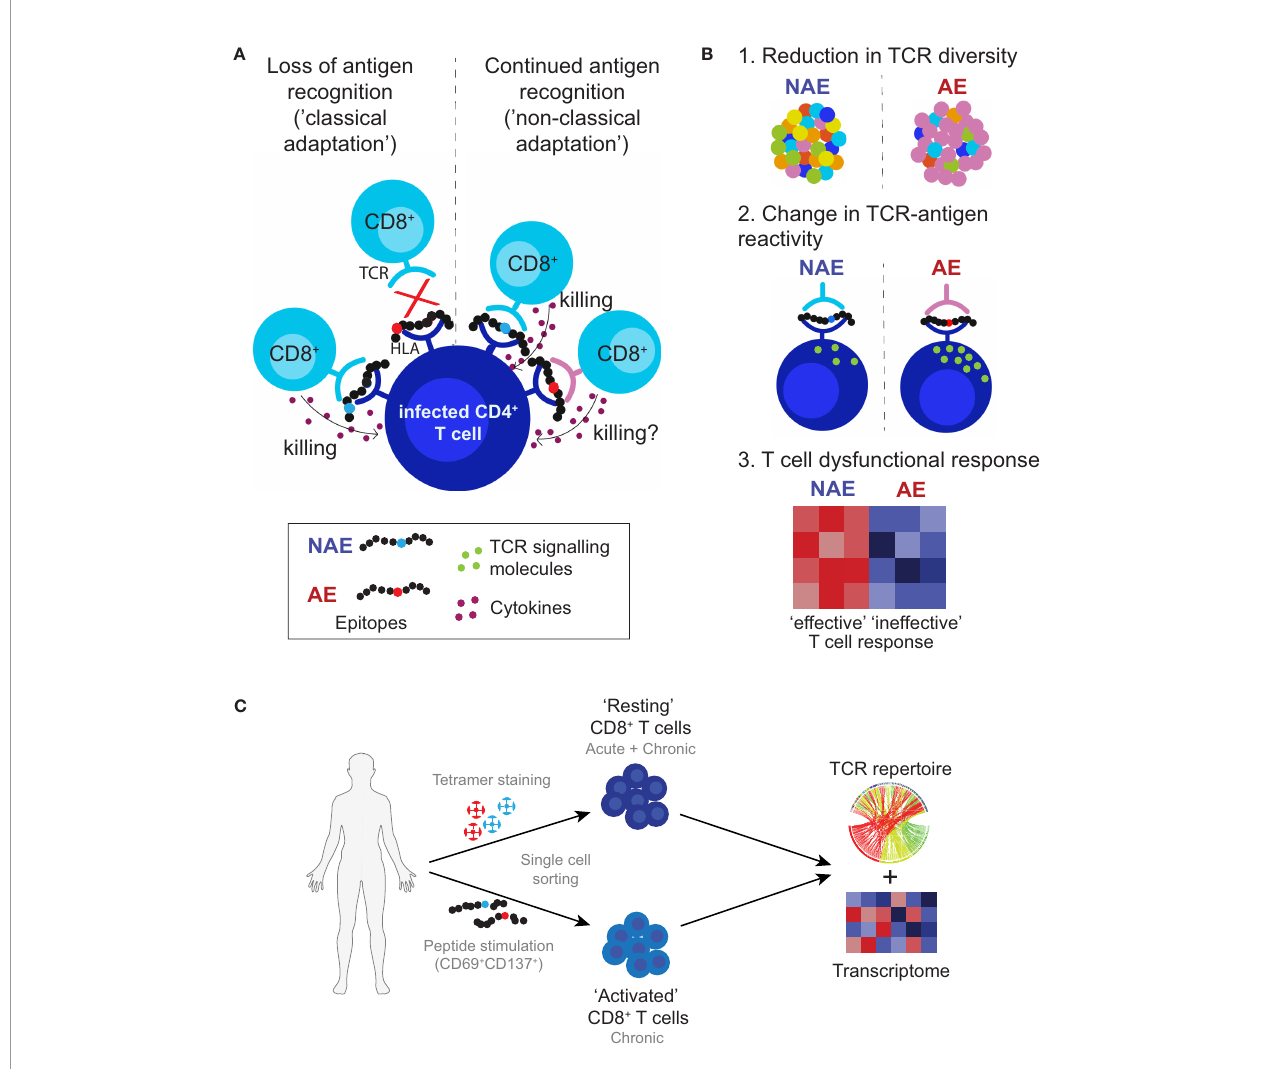
FIGURE 1 | Proposed viral adaptation strategies against anti-HIV T cell immune responses. (A) Schematic depicts classical and non-classical adaptation based on recognition of the HLA-peptide complex by the TCR. (B) Lists the three main proposed mechanisms of non-classical adaptation tested in this study: 1. reduction in TCR diversity or activation of new TCR clonotypes; 2. differences in TCR-peptide-HLA antigen speci fi c reactivity that affect T cell signalling; and 3. alterations in the interaction between the TCR and HLA-peptide complex leading to ineffective T cell responses. (C) Approach used in this study to identify and characterize antigen- speci fi c CD8 + T cells. Cells were single cell sorted using HLA class I tetramers for the NAE- and AE-form of an epitope (assigned as ‘ resting ’ CD8 + T cells) and/or based on CD69 and CD137 expression after peptide stimulation with either the NAE or AE form of an epitope (assigned as ‘ activated ’ CD8 + T cells). All cells then underwent TCR sequencing and for select epitopes RNA sequencing to assess TCR repertoire and transcriptome pro fi les,